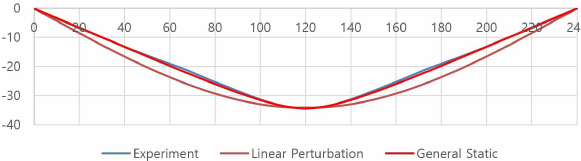
Figure 21: Comparison of bending deformation values on laminate type